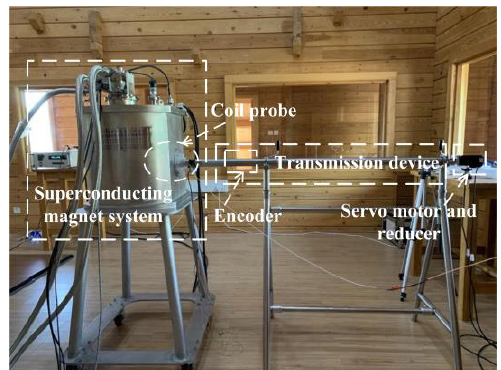
Figure 3. Actual measurement system.